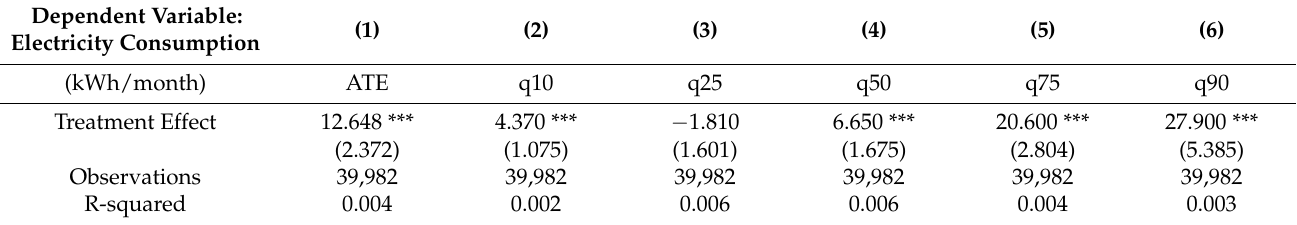
Table 5. Quantile difference-in-differences (DID) regression results.